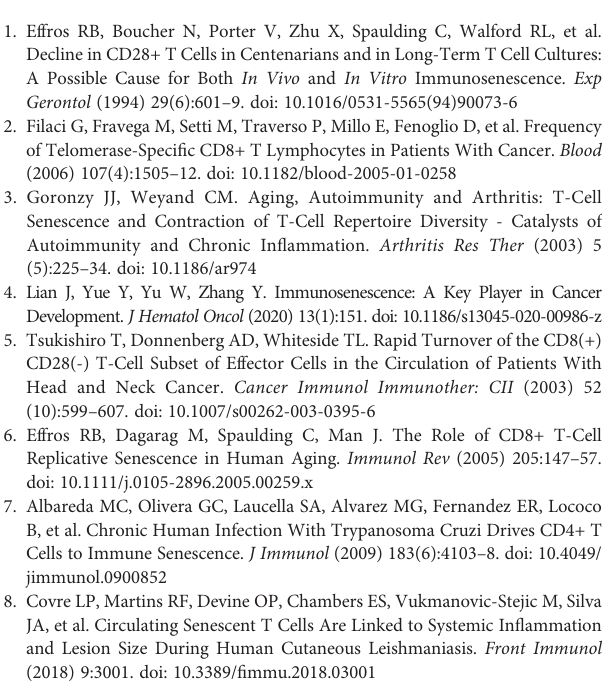
Supplementary Figure 5 | Senescent CD4 + T cells from invaded/metastatic tumor-draining lymph nodes express inhibitory receptors and are highly polyfunctional cells. Line graphs show frequency of CD4 + T cells from invaded/ metastatic tumor-draining lymph nodes, expressing PD-1 and TIGIT (A) or co- expressing TNF and IFN g or expressing CD107a (B) (after PMA/Ionomycin stimulation) within EM/EMRA populations and within DN and DP subsets as indicated in graphs. Each line represents a sample analyzed. Paired t -tests were used to compared DN and DP subsets ( p are indicated in each graph). Supplementary Figure 6 | Gene expression pro fi les of CD4 + T subsets from peripheral blood from BC patients and HDs. (A) Principal component analysis of